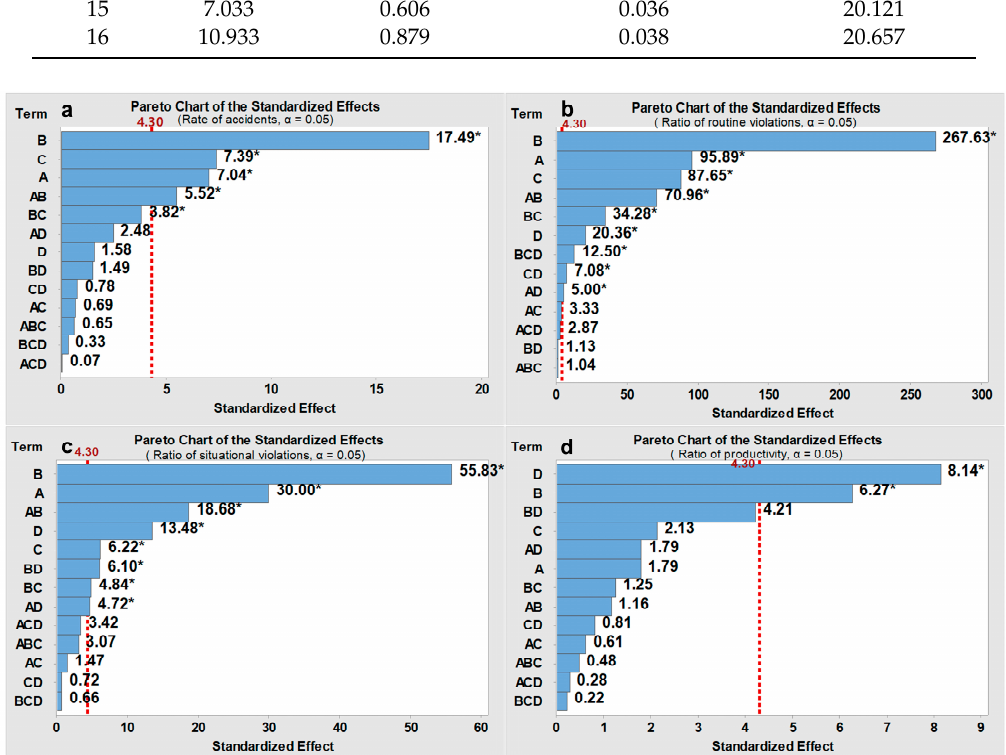
Figure 8. Pareto charts of the standardized effects for the “modest” onsite conditions. Note: ( a ) = safeGoal; ( b ) = proacMan; ( c ) = median contagionPro; ( d ) = productionIncr; * = p < 0.05. Table 7. Average values of response variables for the “high” hazard onsite condition.